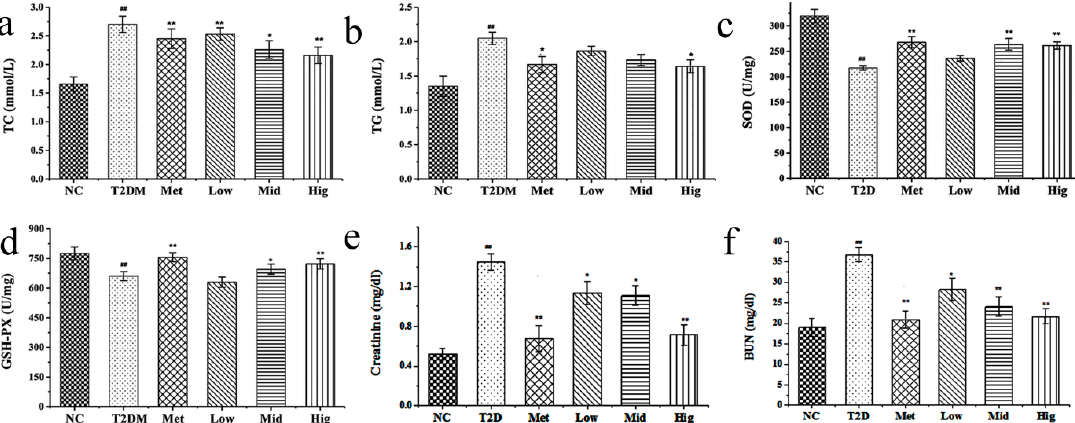
Figure 3. Effects of purified anthraquinone-Glycoside from Rheum palmatum L. (PAGR) on total cholesterol (TC) ( a ), triglyceride (TG) ( b ), superoxide dismutase (SOD) ( c ), glutathione peroxidase (GSH-PX) ( d ), creatinine ( e ), and BUN ( f ) in serum of rats. NC, normal group; T2DM, type 2 diabetes mellitus; Met, metformin group; Low, low group (100mg/kg); Mid, middle group (200mg/kg); Hig, high group (400mg/kg).The data were expressed as mean ±SD ( n = 10), # P < 0.05, ## P < 0.01 vs. NC group. * P < 0.05, ** P < 0.01 vs. T2DM group.